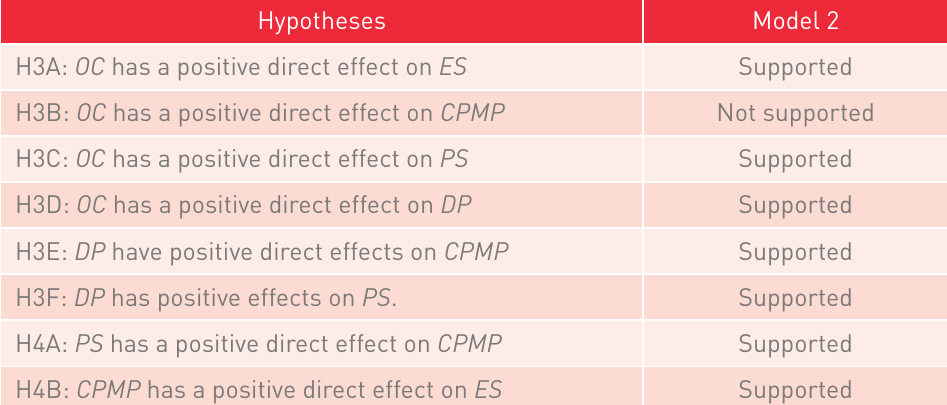
Hypothesis direct